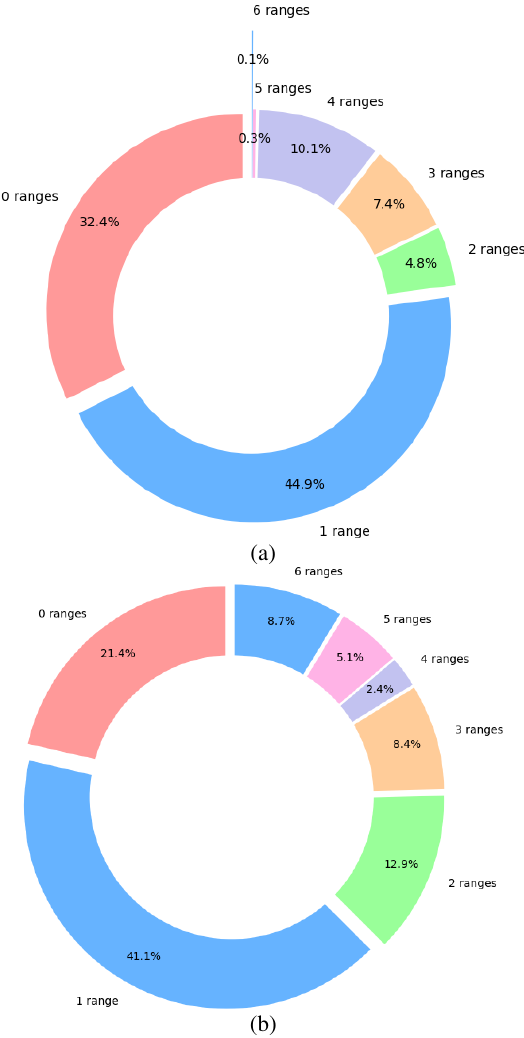
Figure 7. Comparison between (a) left and (b) right V2V UWB Pozyx network on the number of simultaneously available measurements (percentage of the cases).